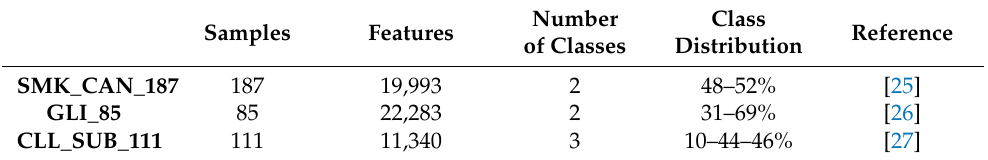
Table 6. Datasets employed in our comparative